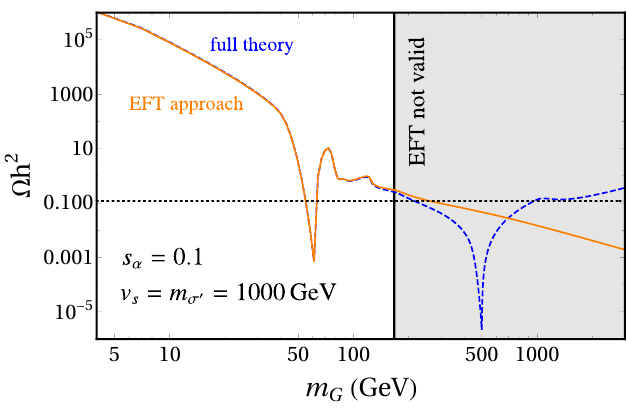
Figure 12. Comparison of the relic abundance between the PNGB effective Lagrangian with the Higgs field, eq. (6.1) (orange line), and the full theory for the quadratic model in eq. (3.15), which also includes the radial mode σ 0 (blue dashed line). The correct value for the relic abundance is shown as a black dotted line, e.g., the region above is excluded and in the region below the PNGB is